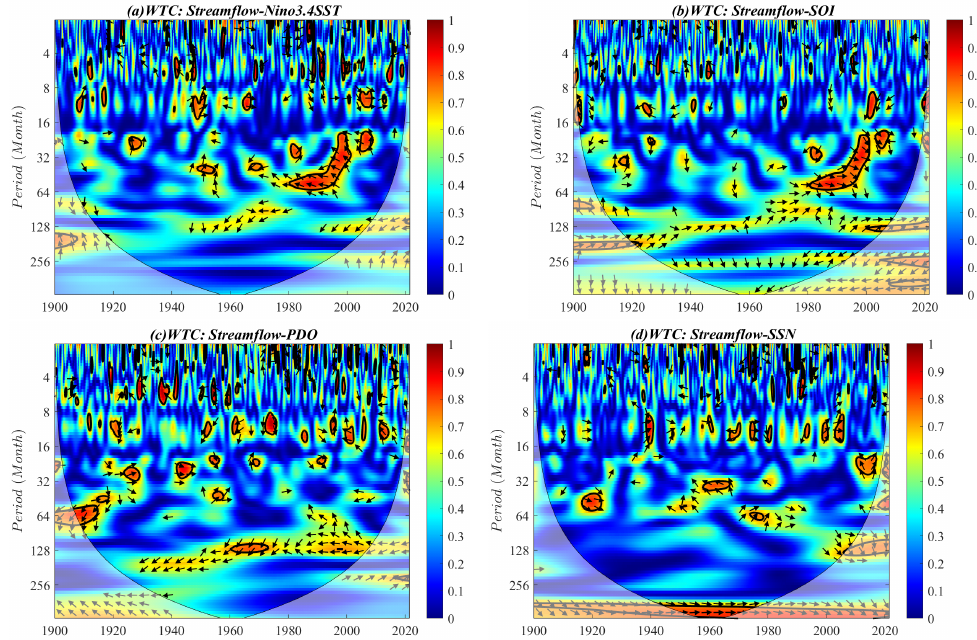
Figure 10. Wavelet coherent spectrums between monthly streamflow and telecorrelation index time series. ( a ) Streamflow-Nino3.4 SST; ( b ) Streamflow-SOI; ( c ) Streamflow-PDO; ( d )